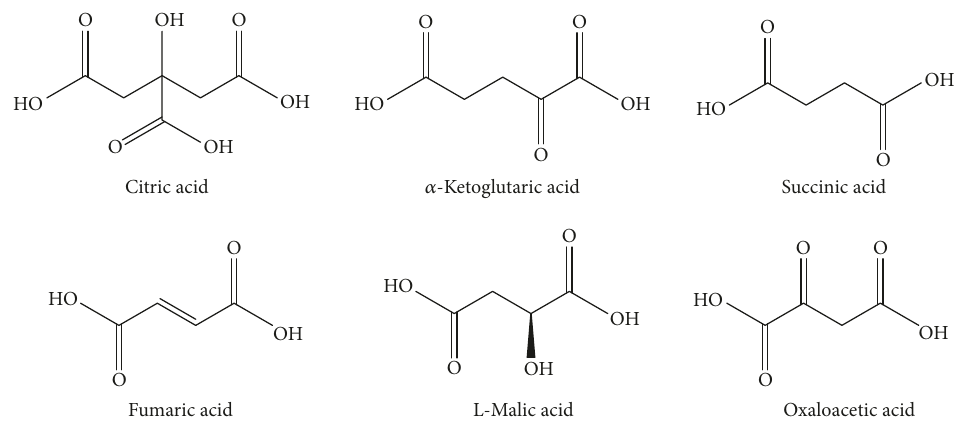
Figure 1: Chemical structure of TCA cycle